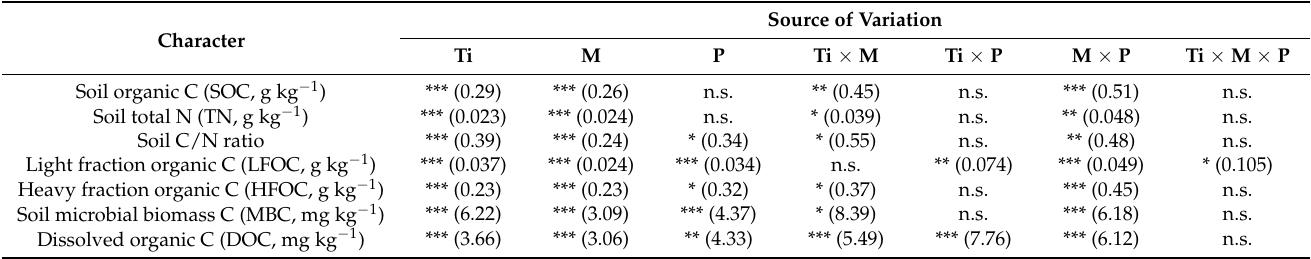
Table 2. Repeated measures ANOVA for the effect of time (Ti), film mulching (M), and phosphorus application (P) on soil organic C (SOC), total N (TN), C/N ratio, and SOC fractions (LFOC, HFOC, MBC, and